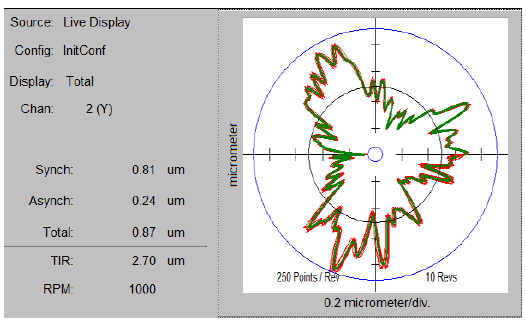
Figure 10. Result diagram of spindle radial rotation errors.